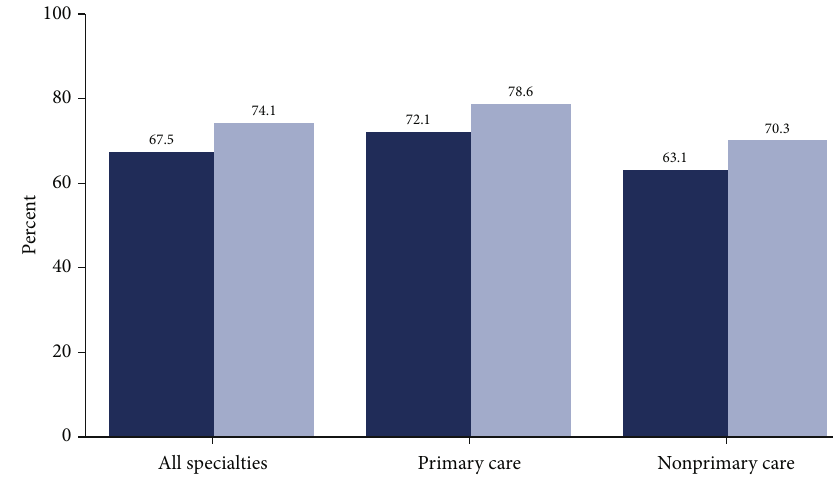
Figure 3: Proportion of measures for basketball curriculum